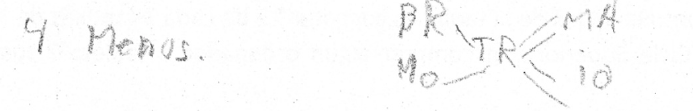
Figure 8. Correct answer of Q4. Tree diagram strategy.